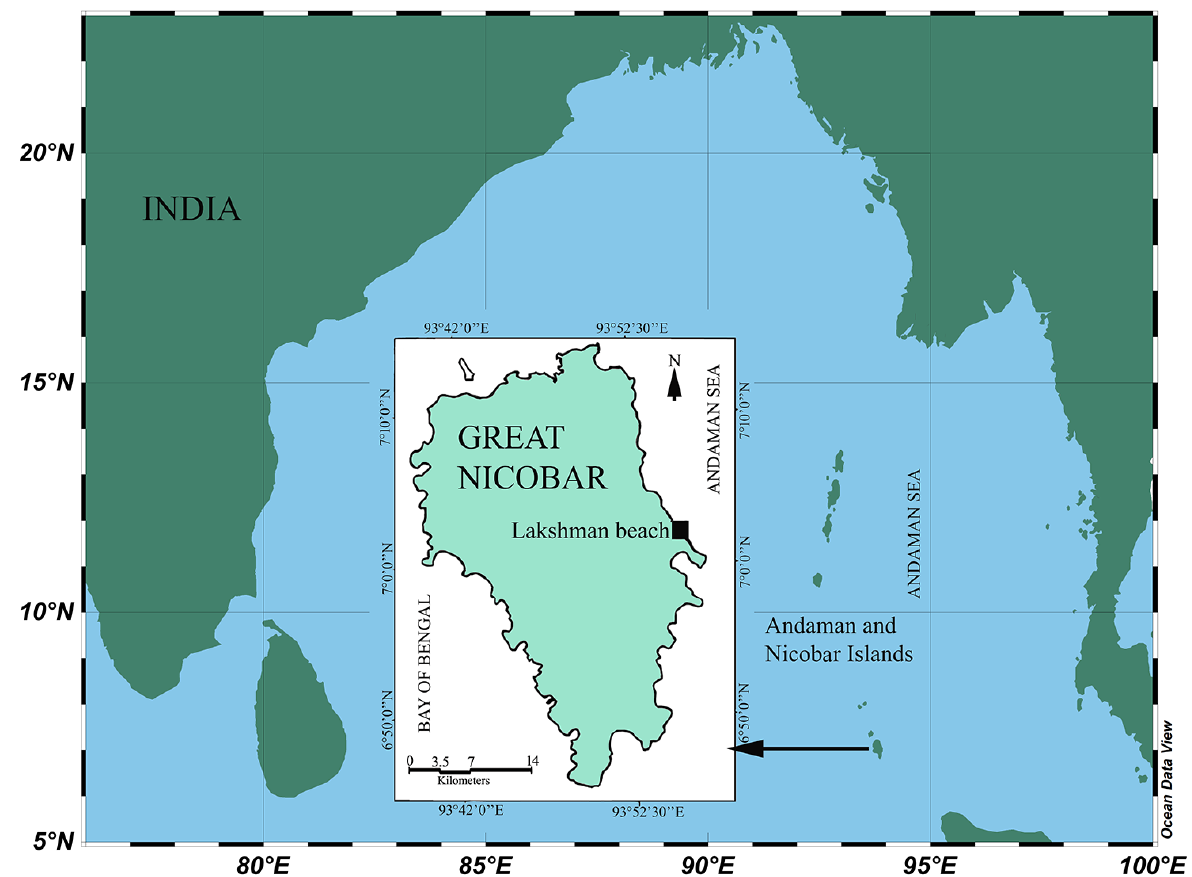
Figure 1. Map showing sampling location at Great Nicobar Island, Andaman and Nicobar